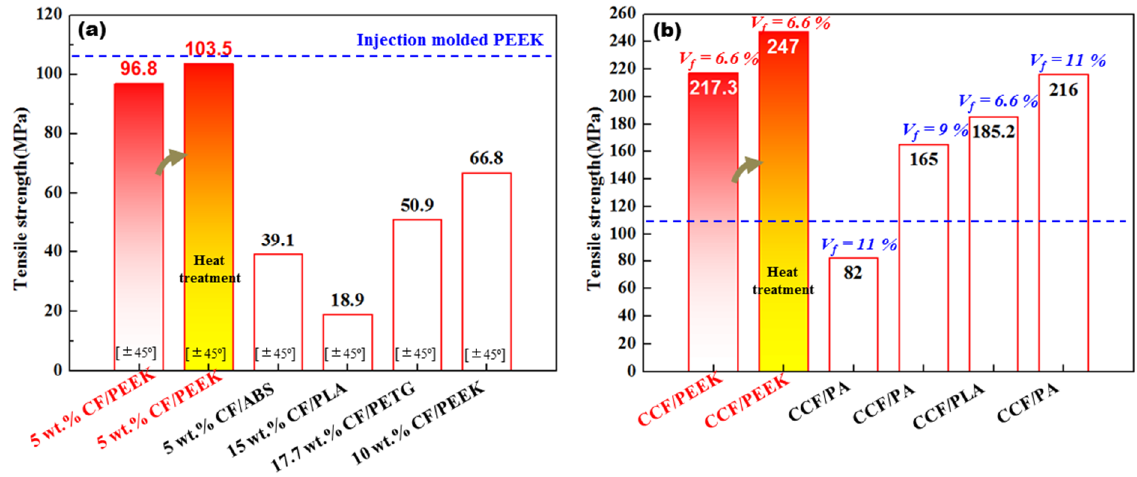
Figure 14. Tensile strength of FDM 3D-printed fiber-reinforced PEEK composites in this study compared with those of FDM 3D-printed fiber-reinforced polymer composites in the literature [31–38]: ( a ) short-fiber-reinforced polymer composites; ( b ) continuous-fiber-reinforced polymer composites.